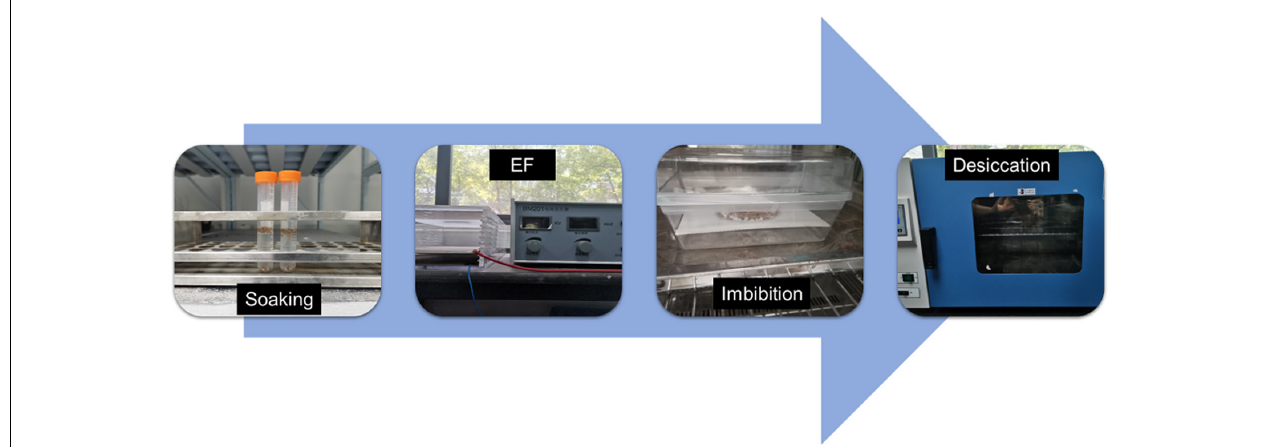
FIGURE 1 | Processing protocols of the HEHP treatment. EF: high voltage electrostatic field treatment.